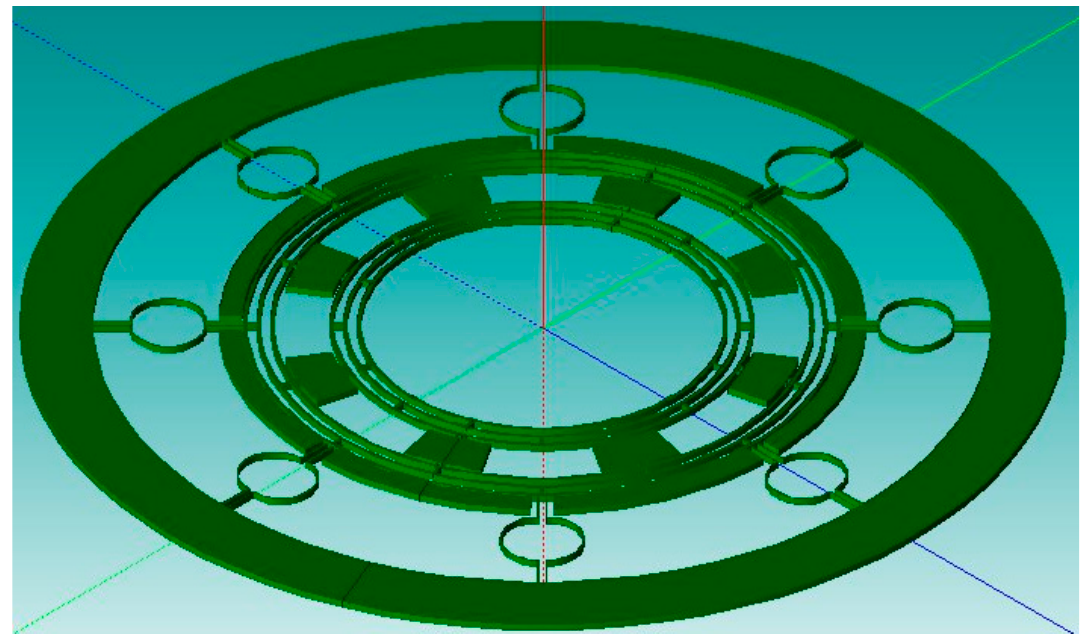
Figure 18. Design of a multi-ring vibrating gyroscope [57].